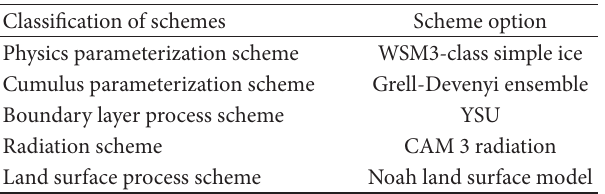
Table 1: Parameterization scheme of physical processes in the WRF